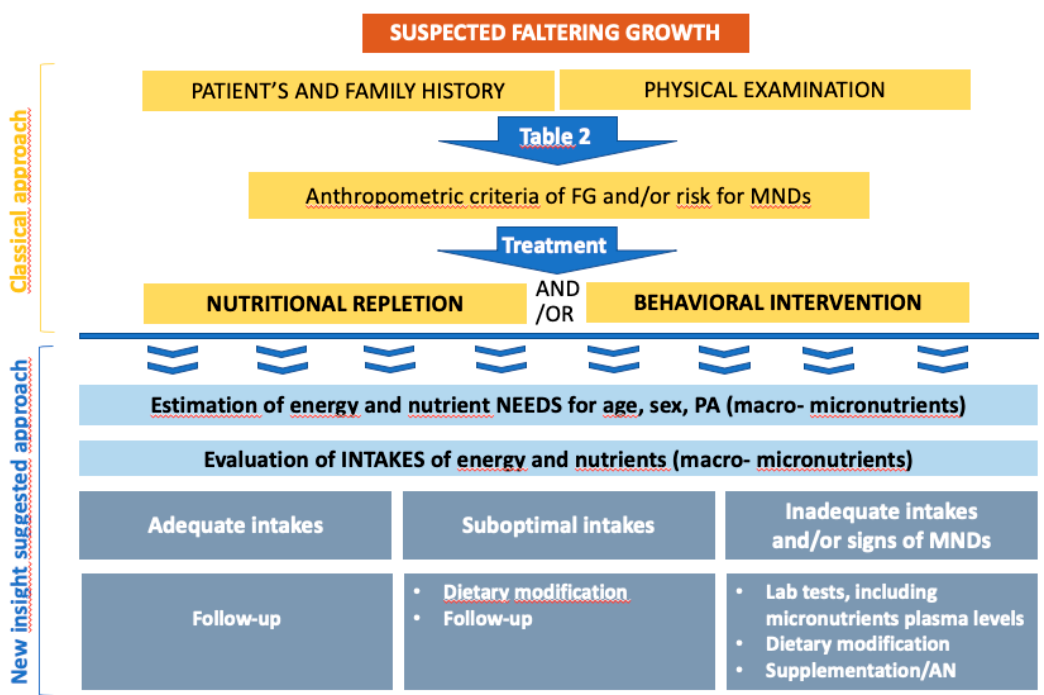
Figure1. Classical and additional treatment of faltering growth. PA: physical activity; AN: artificial